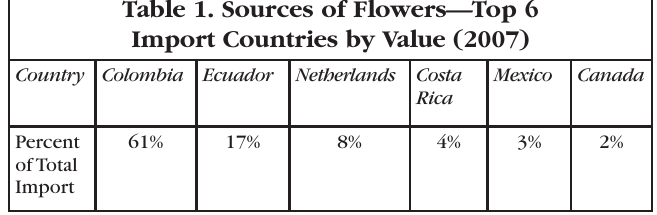
Table 1. Sources of Flowers—Top 6 Import Countries by Value